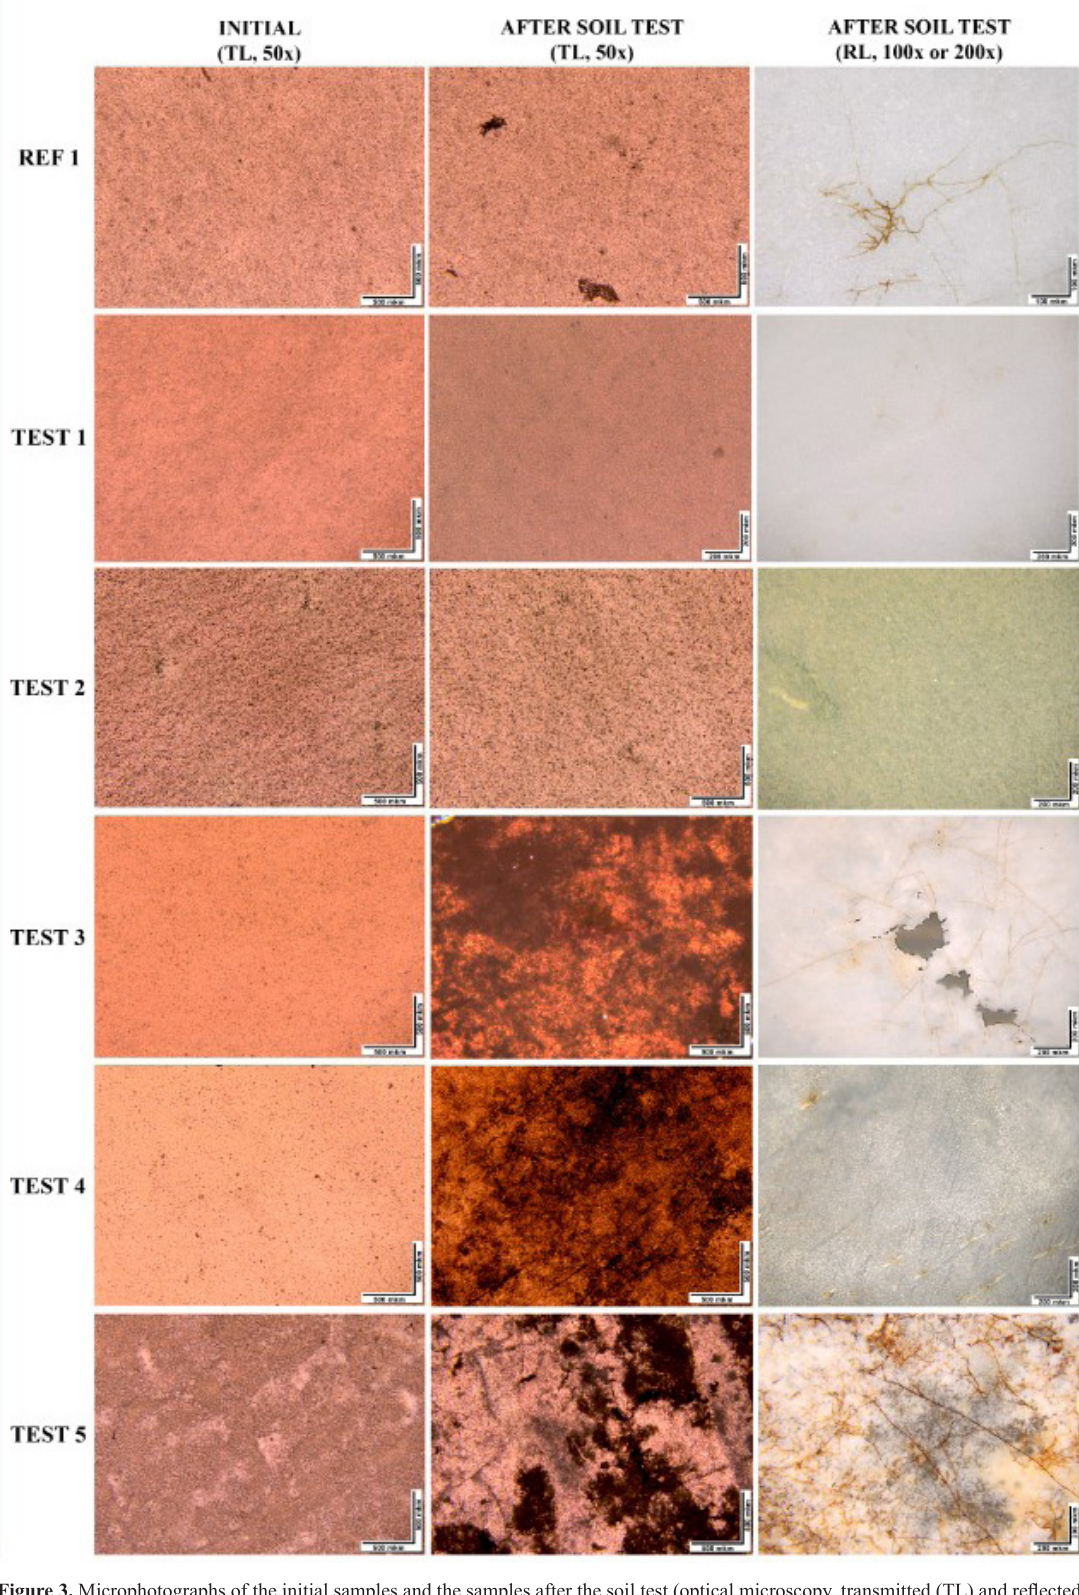
Figure 3. Microphotographs of the initial samples and the samples after the soil test (optical microscopy, transmitted (TL) and reflected (RL) light, magnification of 50×, 100×, and